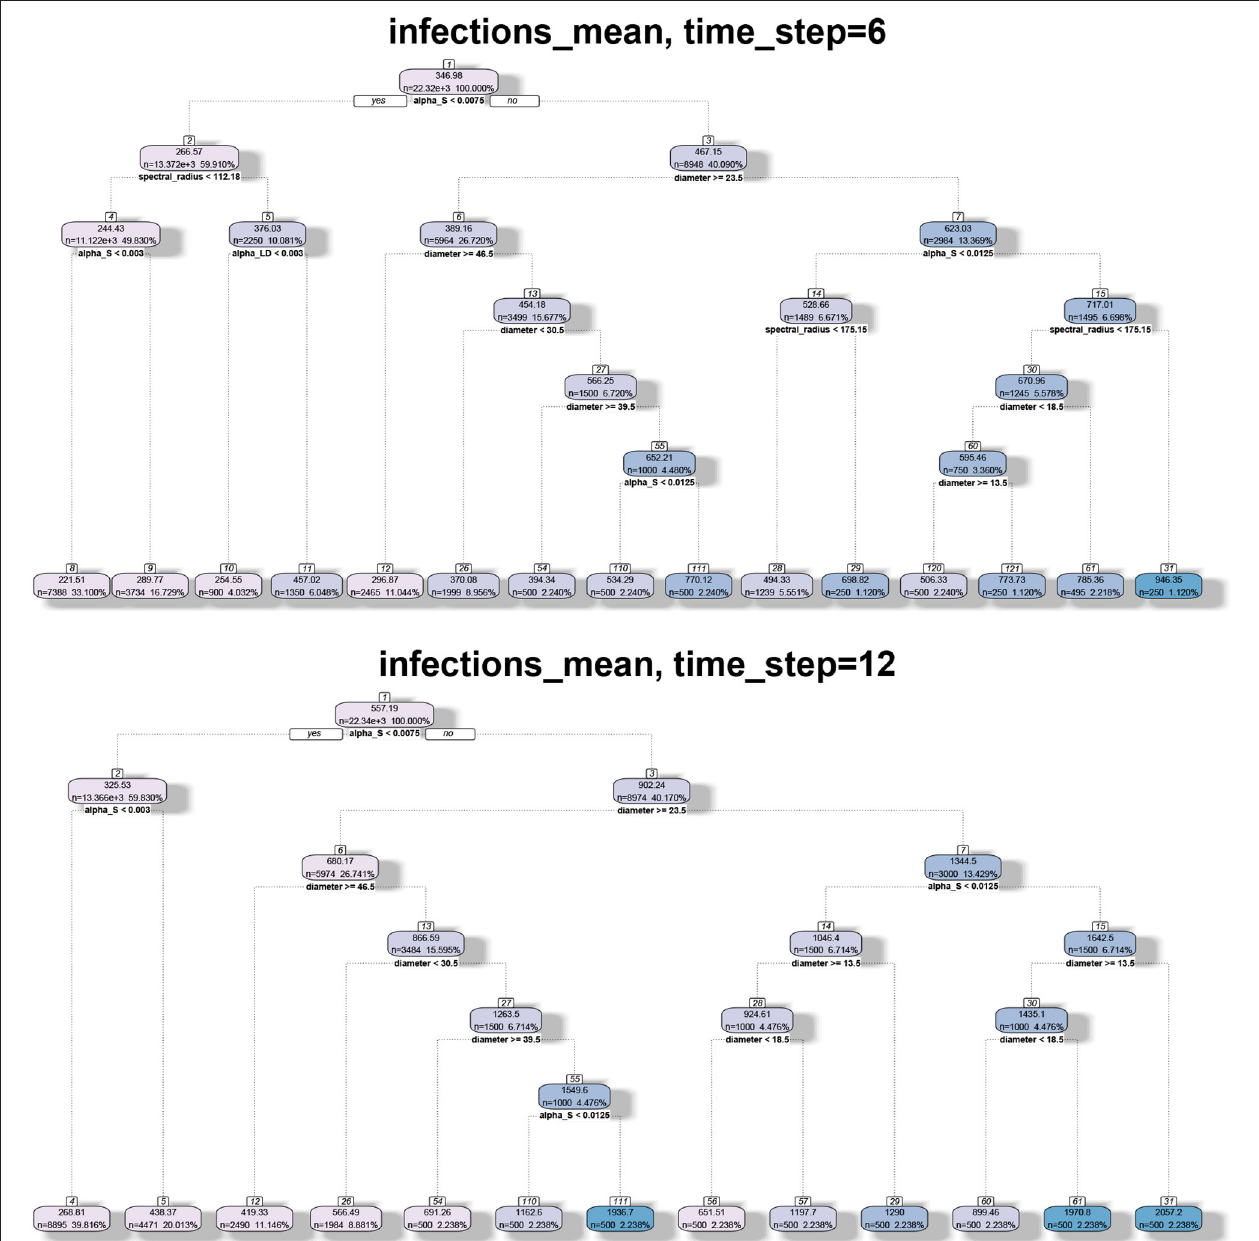
FIGURE 8 | Regression tree analysis of simulation results where the independent variables are the spectral radius and diameter of the networks and the observed variable is the mean number of infections at different time steps T .